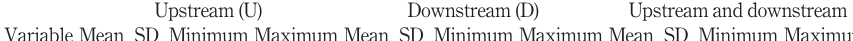
Table 2. Descriptive results